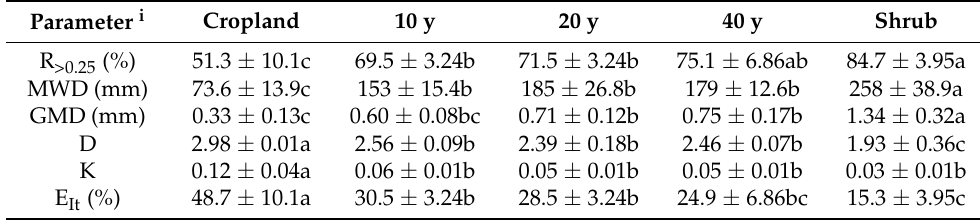
Table 2. Stability characteristics of soil aggregate.